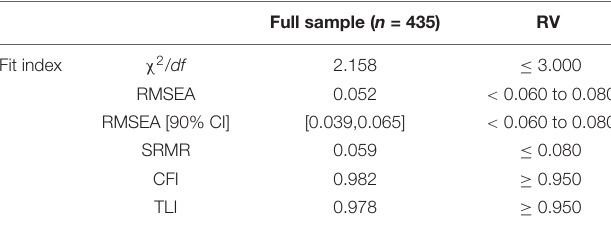
TABLE 2 | SBS-12 fit indices for second-order confirmatory factor analysis